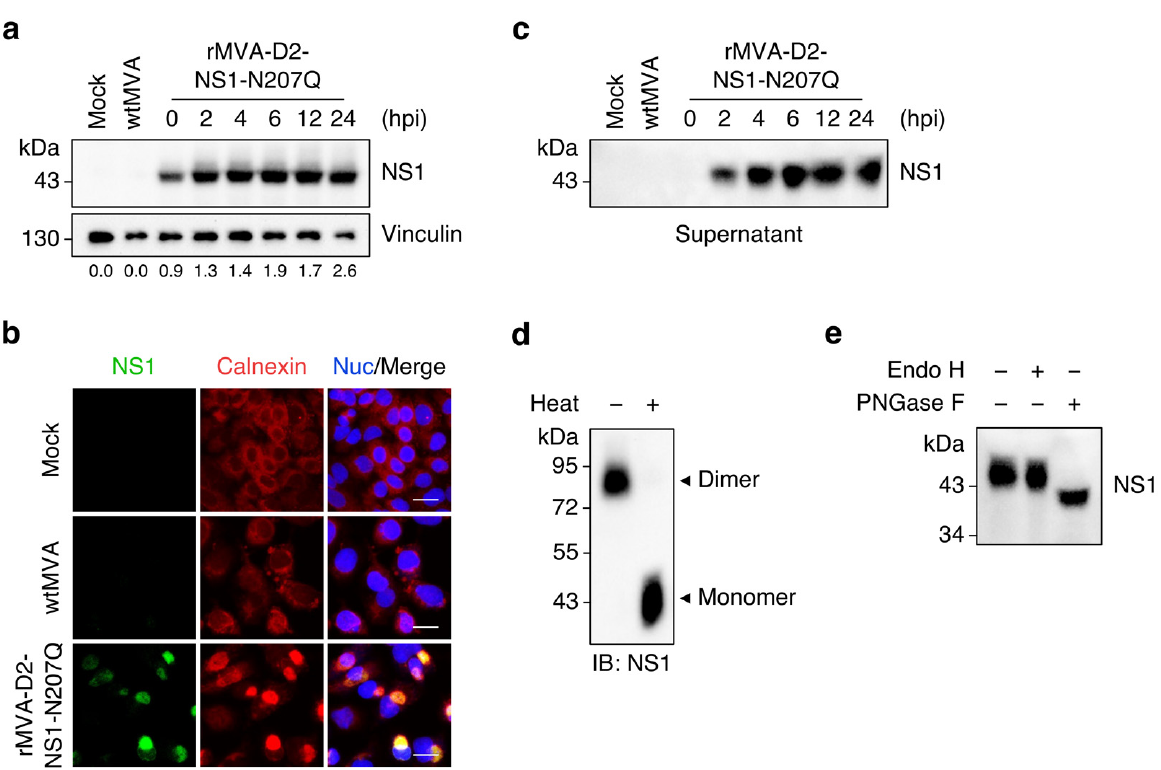
Figure 2. Characterisation of transgene expression by rMVA-D2-NS1-N207Q. ( a ) HeLa cells were mock-infected or infected with wtMVA or rMVA-D2-NS1-N207Q (MOI = 3) and lysed at 24 hpi (mock and wtMVA) or at the indicated time points (rMVA-D2-NS1-N207Q). Whole-cell lysates were analysed by Western blotting with antibodies against DENV NS1 and vinculin (loading control). Relative NS1 levels were determined by densitometric analysis. Note that the 0 hpi time point was collected immediately after 1 h of virus adsorption. ( b ) A549 cells were mock-infected or infected with wtMVA or rMVA-D2-NS1-N207Q (MOI = 3). At 24 hpi, cells were analysed by immunofluorescence staining for DENV NS1 (green) and calnexin (red). Nuclei were stained with Hoechst 33342 (blue). Scale bars, 20 µ m. ( c – e ) HeLa cells were mock-infected or infected with wtMVA or rMVA-D2-NS1-N207Q (MOI = 3). ( c ) Supernatant samples were collected at 24 hpi (mock and wtMVA) or at the indicated time points (rMVA-D2-NS1-N207Q) and analysed by Western blotting with an antibody against DENV NS1. Note that the 0 hpi time point was collected immediately after 1 h of virus adsorption. ( d ) Supernatant samples from cells infected with rMVA-D2-NS1-N207Q were collected at 24 hpi, boiled (or not) for 5 min at 95 ◦ C prior to non-reducing SDS-PAGE, and analysed by Western blotting with an antibody against DENV NS1. ( e ) Supernatant samples from cells infected with rMVA-D2-NS1-N207Q were collected at 24 hpi, left untreated or digested with Endo H or PNGase F, and analysed by Western blotting with an antibody against DENV NS1.